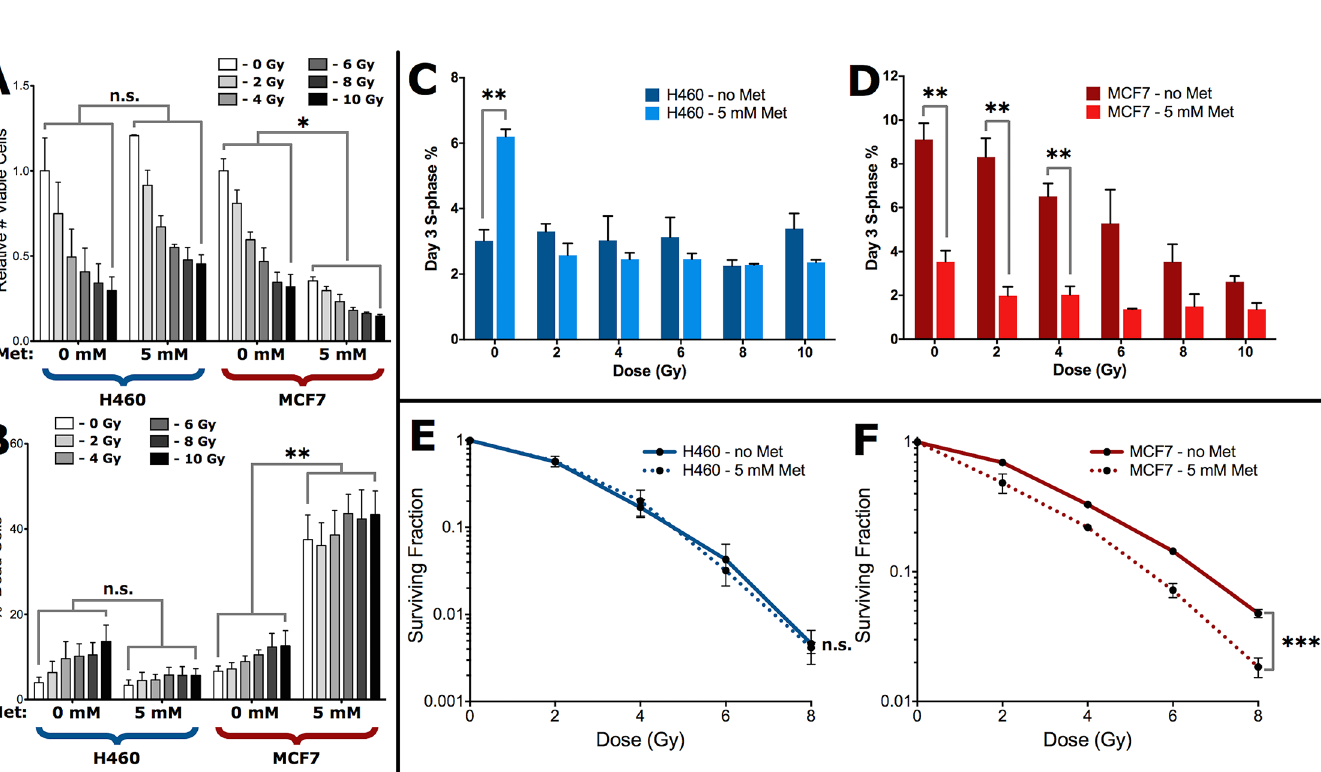
Fig 5. Preferential sensitization of MCF7 cells treated with radiation and metformin. (A) Total numbers of live and (B) dead cells in metformin co-treated H460 and MCF7 cultures were counted in triplicate at 3-days post-irradiation. Viable cell counts in (A) are relative to the untreated control for each cell line. Statistical significance tests shown apply to each dose-matched sample pairing within each group. Cell cycle distributions from each culture were determined via propidium iodide staining, and S-phase fractions for metformin co-treated (C) H460 and (D) MCF7 cells are shown at 3-days post-irradiation. Data are the mean ± SE from 3 independent experiments. * p < 0.05, ** p < 0.01, and n.s. not significant (unpaired two-tailed t-test). Clonogenic survival of metformin co- treated (E) H460 and (F) MCF7 cells performed 1 day post-treatment as described in the Materials and Methods. Data are the mean ± SE from three independent experiments, each cultured in triplicate. n.s. — no significant difference between curves, *** p < 0.001 (extra sum-of-squares F test).